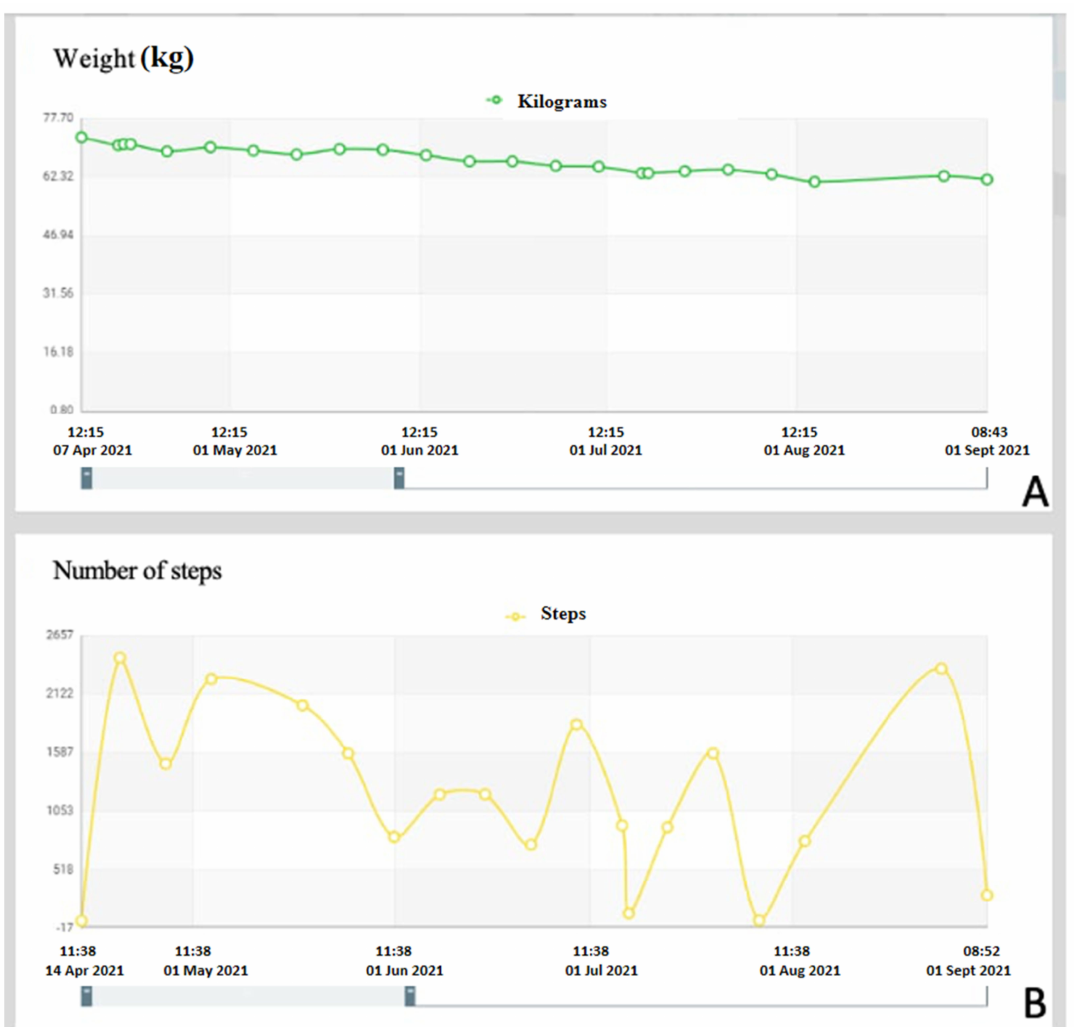
Figure 2. Examples of graphs obtained through the Telesalute dashboard. ( A ) Example of graphic representation relating to the progression of the load on the affected limb recorded by the patient. ( B ) Example of graphic representation relating to the number of steps recorded by the patient during the